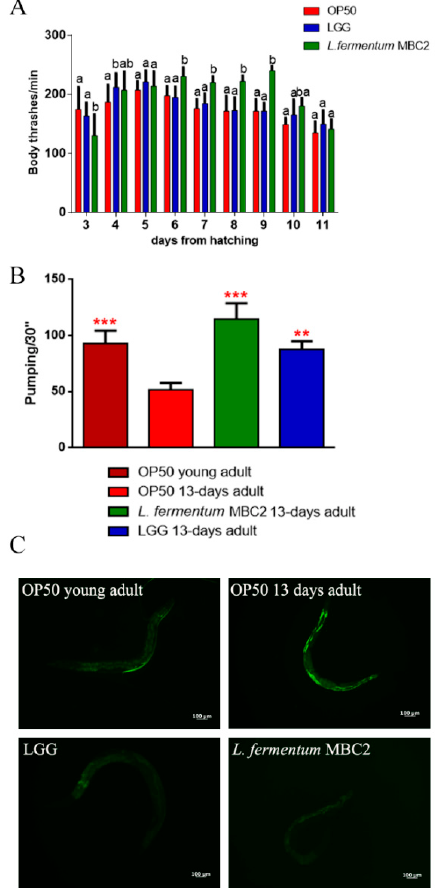
Figure 2. Analysis of aging markers in C. elegans fed L. fermentum MBC2. ( A ) Body bending of C. elegans fed Lactobacillus strains with respect to OP50, measured for 30 s. Bars represent the mean of three independent experiments. Different letters indicate significant differences ( p < 0.05) ( B ) Pumping rate of 13-days-old worms, measured for 30 s and determined from the mean of 10 worms for each bacterial strain. Worms fed OP50 or LGG were used as controls. Statistical analysis was evaluated by one-way ANOVA with the Bonferroni post-test; asterisks indicate significant differences (** p <0.01, *** p <0.001). Bars represent the mean of three independent experiments. ( C ) Autofluorescence of lipofuscin granules in C. elegans fed L. fermentum MBC2, LGG and OP50 on day 13. Ten worms were used for each measurement. Scale bar = 100 μ m.